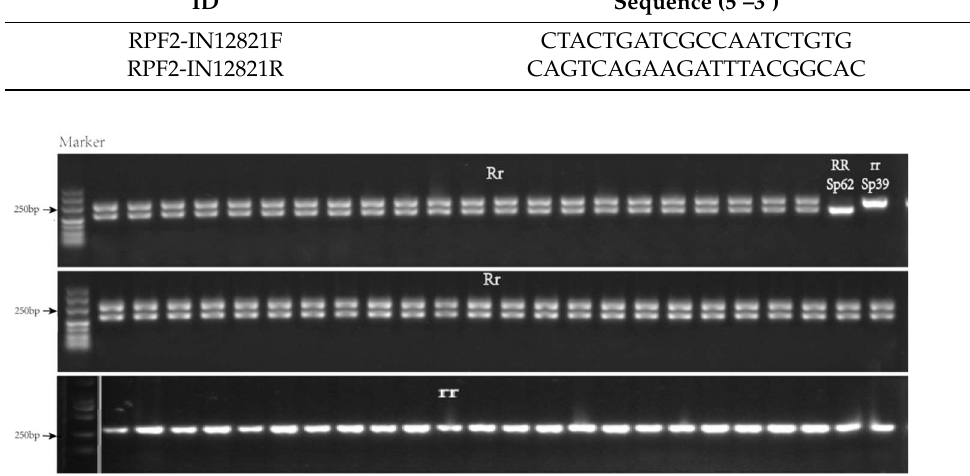
Figure 3. Amplification result of RPF2-IN12821 in BC 1.